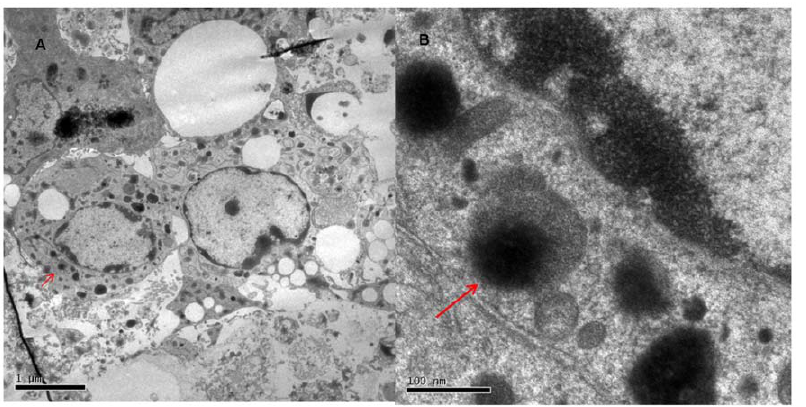
Figure 5. Transmission electron microscopy of the Step 4 clusters in (a) low power and (b) high power magnification. There are secretory granules present in the cytoplasm of the cells denoted by